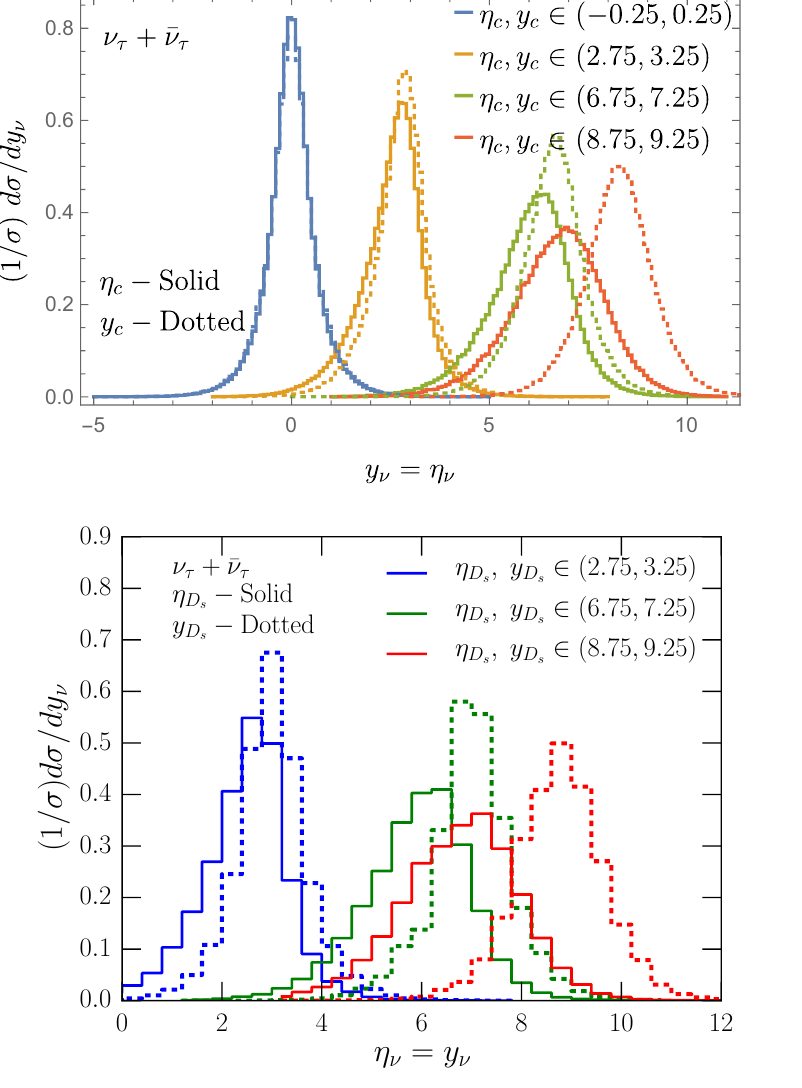
Figure 2. Upper: the distribution of y ν = η ν for ν τ + ¯ ν τ that come from D s decays that orig- inate from charm quark rapidities (dotted histograms) and charm quark pseudo-rapidities (solid histograms) in the ranges [ − 0 . 25 , 0 . 25] , [2 . 75 , 3 . 25] , [6 . 75 , 7 . 25] and [8 . 75 , 9 . 25] . Lower: the distri- bution of y ν = η ν for ν τ + ¯ ν τ that come from D ± decays where the D ± rapidities y (dotted s s D ± s histograms) and D ± pseudo-rapidities η D (solid histograms) lie in the ranges [2 . 75 , 3 . 25] , [6 . 75 , 7 . 25] s s and [8 . 75 , 9 . 25] . The distributions have unit normalization in each D ± (pseudo)rapidity interval. s √ They refer to D ± produced in pp collisions at s = 14 TeV, using as input ( µ R , µ F ) = (1 , 1) m T, 2 s and h k T i = 0 . 7 GeV